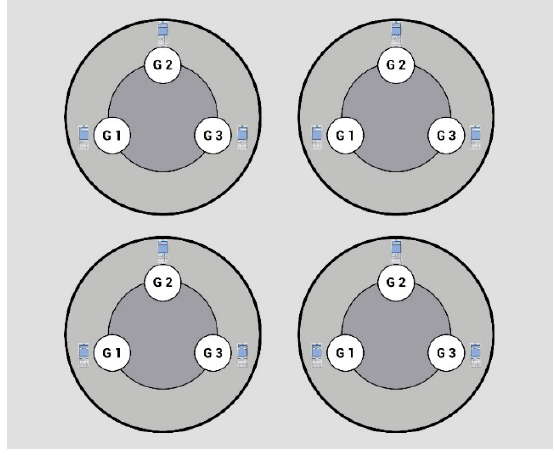
Figure 3. CSCL mobile system.